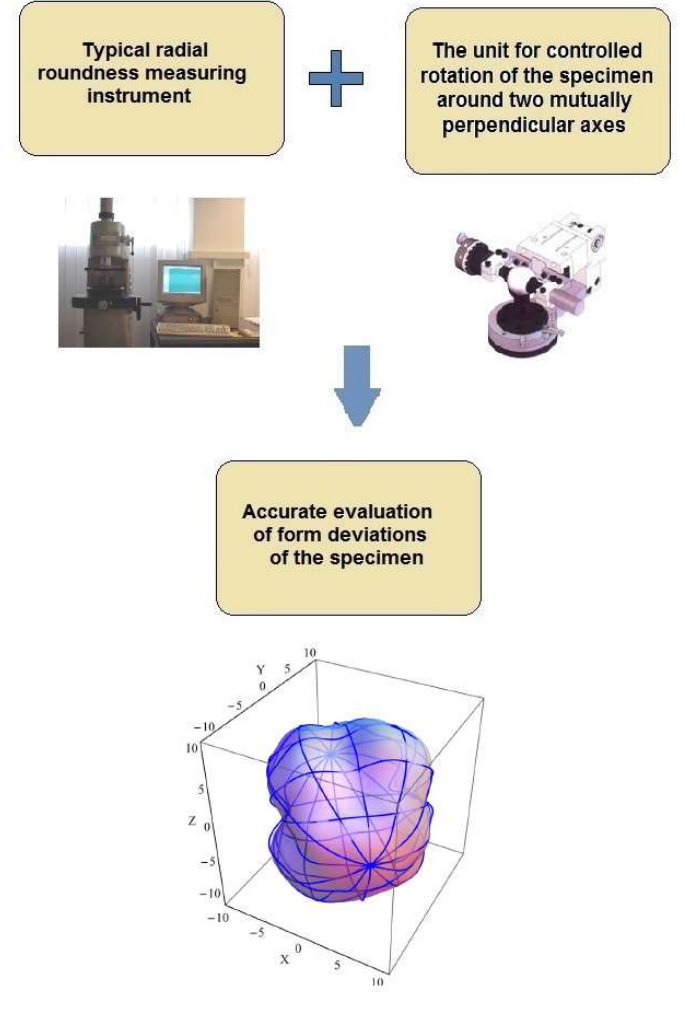
Figure 1. The concept of the sphericity measurement by the radius-change instrument.